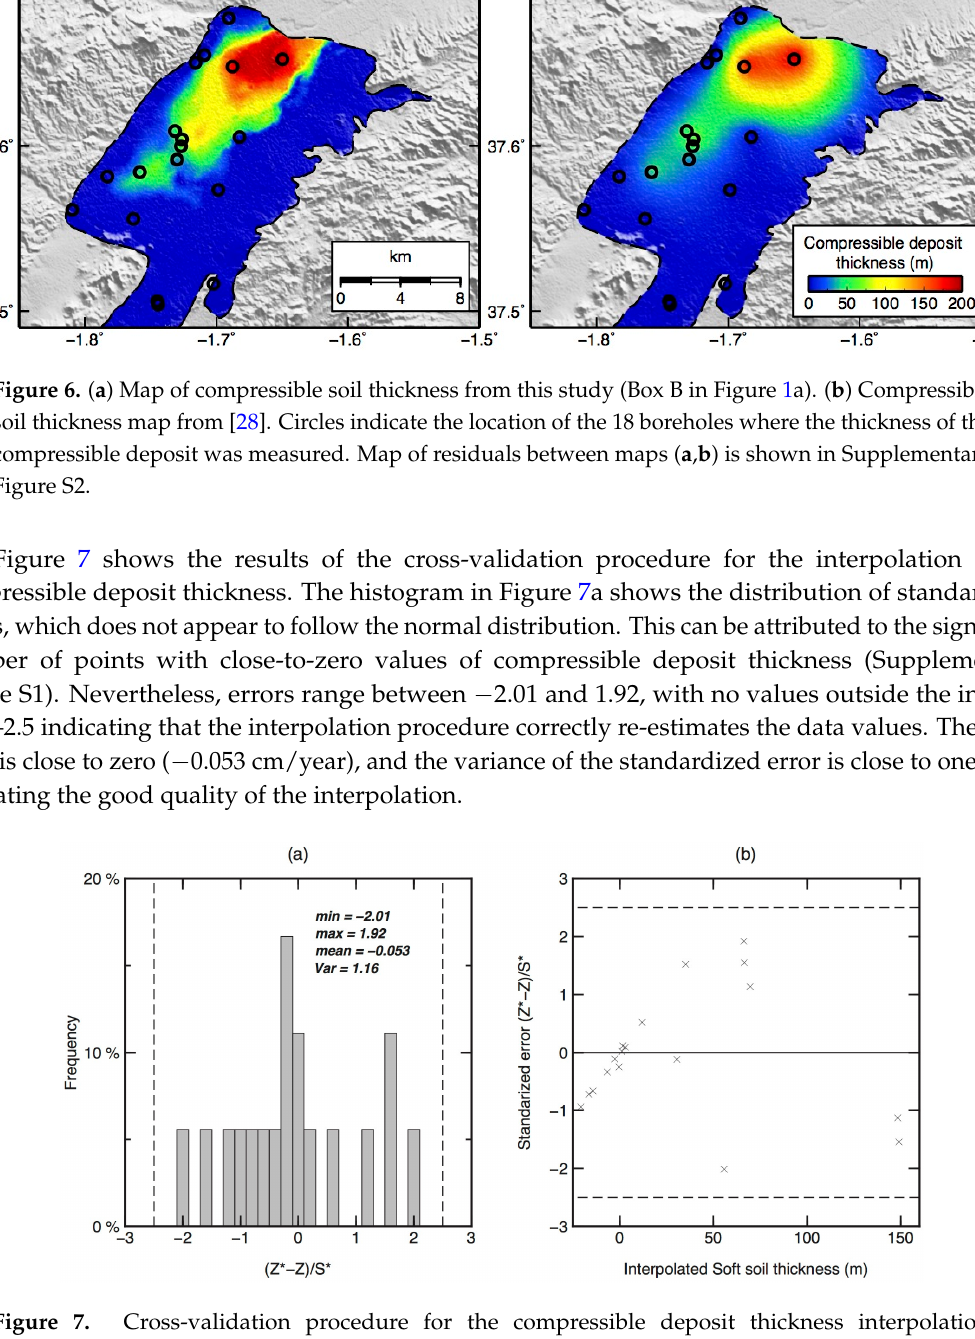
Figure 7. Cross-validation procedure for the compressible deposit thickness interpolation. ( a ) Histogram of the standardized error. The minimum value, maximum value, mean value and variance are indicated. ( b ) Standardized error versus the interpolated thickness of the compressible deposit in the 18 borehole locations.